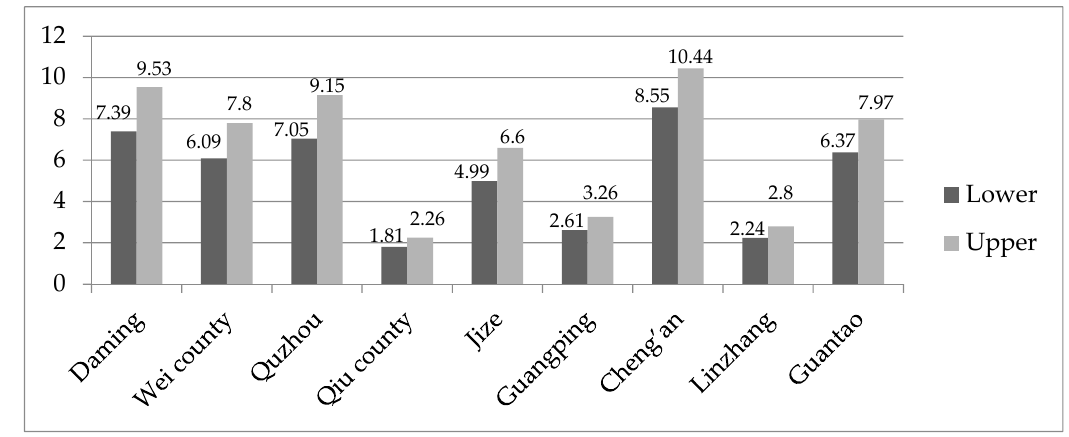
Figure 4. Result of water resources allocation to industry (10 6 m 3 ).